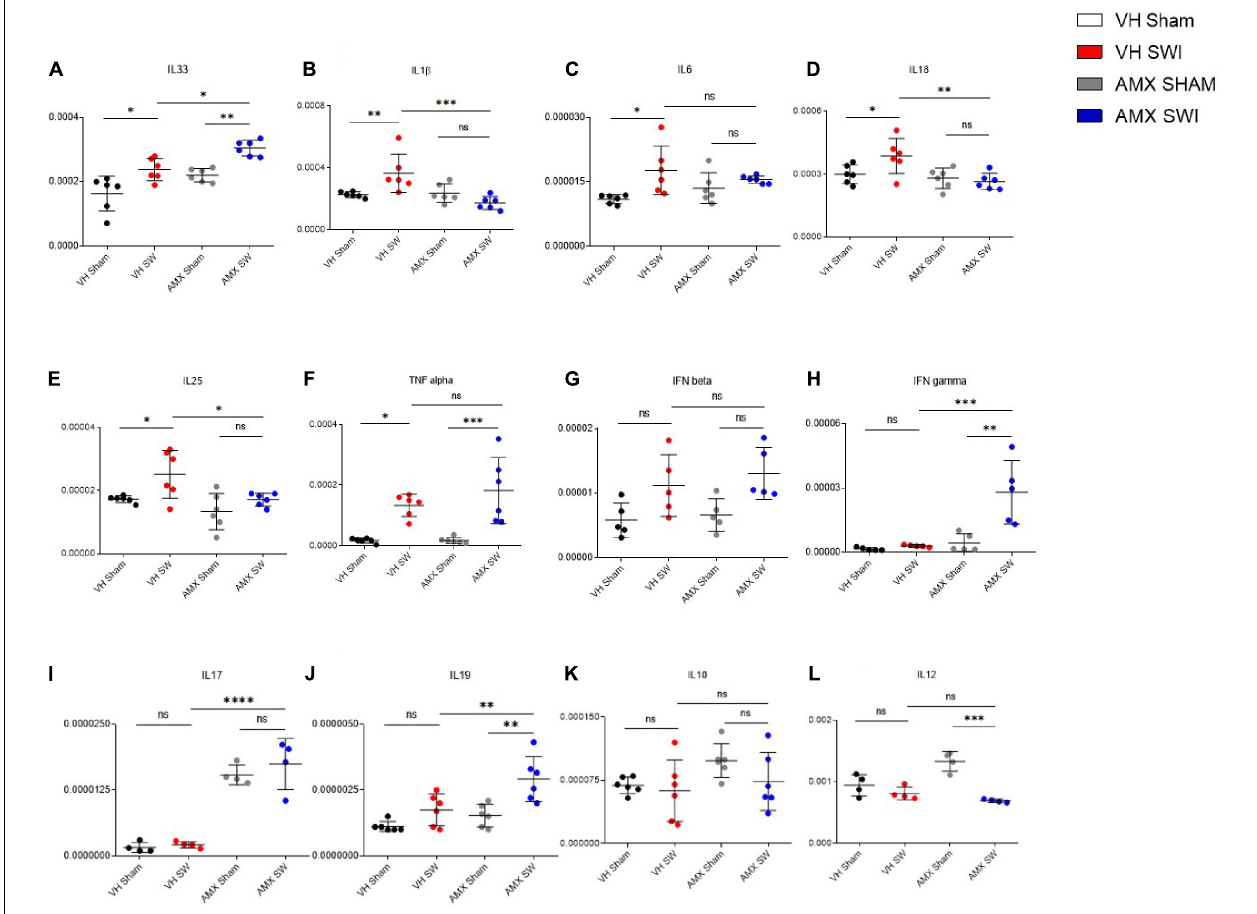
FIGURE 6 | Tbk1 blockade induces a distinct inflammatory cytokines profile upon Stab Wound Injury (SWI). qPCR from whole-biopsy homogenates were obtained from the injury site (or the corresponding anatomical location in sham mice) from animals treated with either vehicle or AMX at 7 dpi. AMX treatment after SWI significantly upregulated the expression of IL-33 (A) , IFN- γ (H) , IL-17 (I) and IL-19 (J) . Interestingly, AMX after SWI (7 dpi) also significantly reduced the expression of IL-1 β (B) , IL-18 (D) , IL-25 (E) . Notably, AMX alone, irrespective of concomitant SWI, substantially increased the levels of IL-17 mRNA (I) . No difference in expression levels was observed upon SWI with or without inhibitor treatment in IL6 (C) , TNF alpha (F) , IFN beta (G) , IL10 (K) , and IL12 (L) . ( n = 3 animals/group with 4 sections/animal. Average ± SD, plus individual data points indicated; two-way ANOVA with Tukey post hoc; ns: not significant, ∗ p < 0.05, ∗∗ p < 0.01, ∗∗∗ p < 0.001, ∗∗∗∗ p < 0.0001; full statistical report in Supplementary Table 8